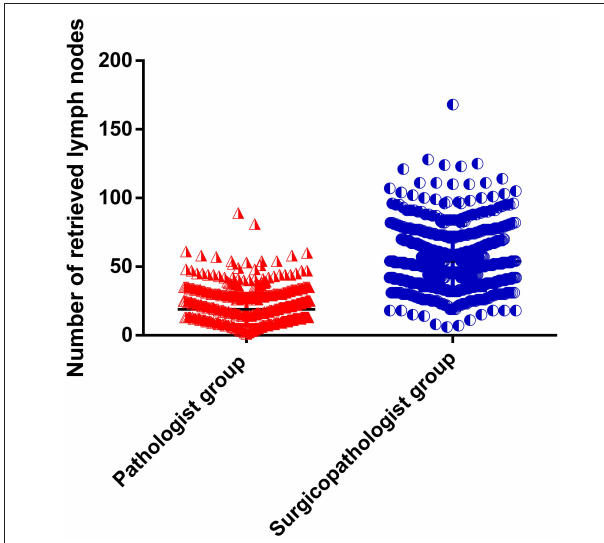
FIGURE 2 | The number of retrieved lymph nodes between the pathologist group and surgicopathologist group.